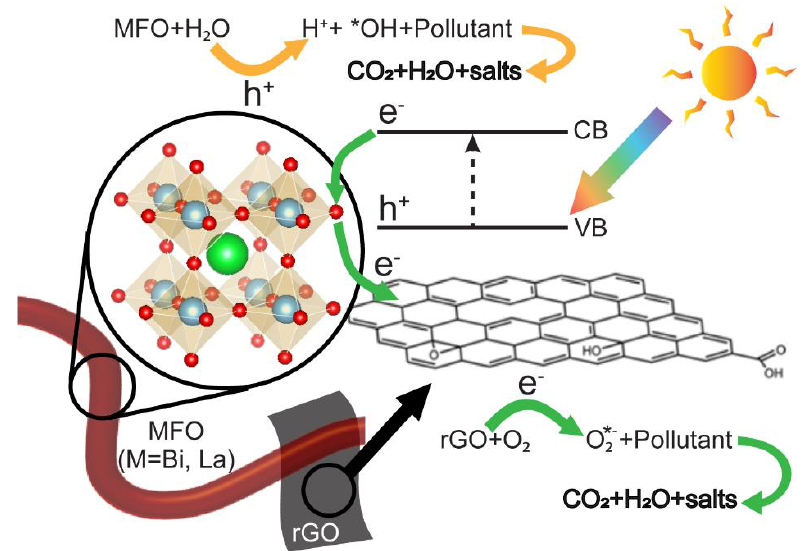
Figure 9. Schematic representation of the dye degradation mechanism by the MFO / rGO composite films due to UV and visible light absorption, followed by the ejection of electrons from the valence bands (VB) to the conduction bands (CB) of MFO nanofibers.